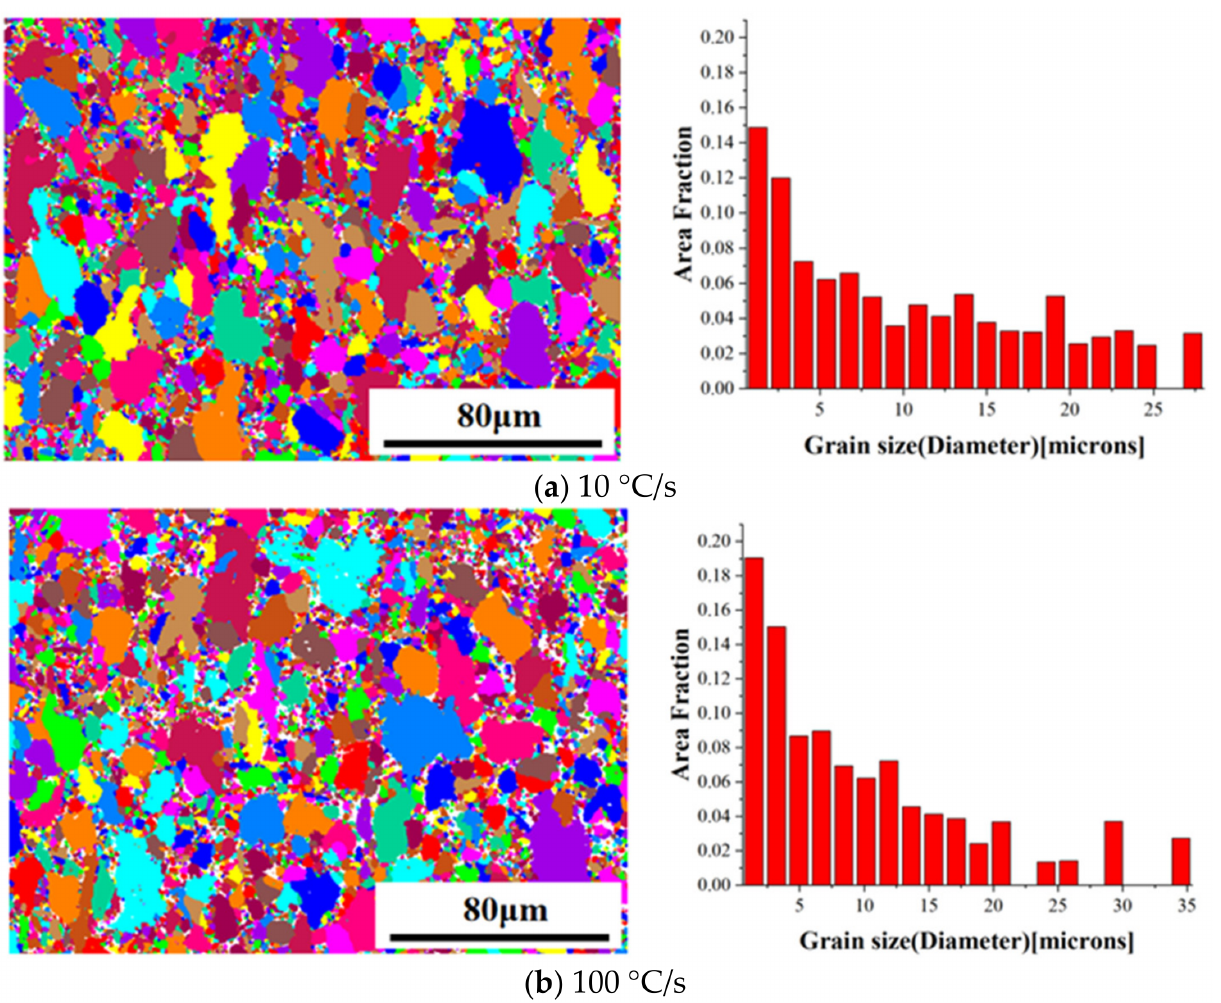
Figure 10. EBSD of the grain microstructure and size of TC4 at different heating rates and a constant forming temperature of 950 ◦